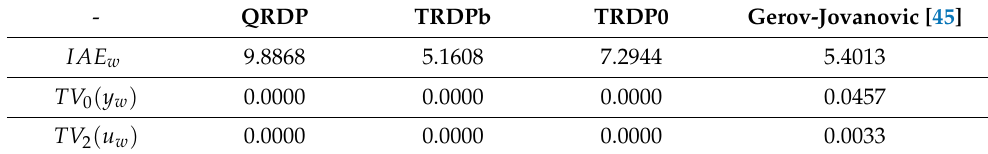
Figure 4. Setpoint step responses of the QRDP PID controller (24) with the prefilter (25), c 1 = 0, b 1 = T o , TRDP PD controller (14) with the prefilter (15), b = T 0 (TRD Pb) and b = 0 (TRDP0) and the PD controller according to Gerov and Jovanovic [45] with the prefilter (15), b = 0 (GJ). Table 1. Performance measures corresponding to the setpoint step responses in Figure